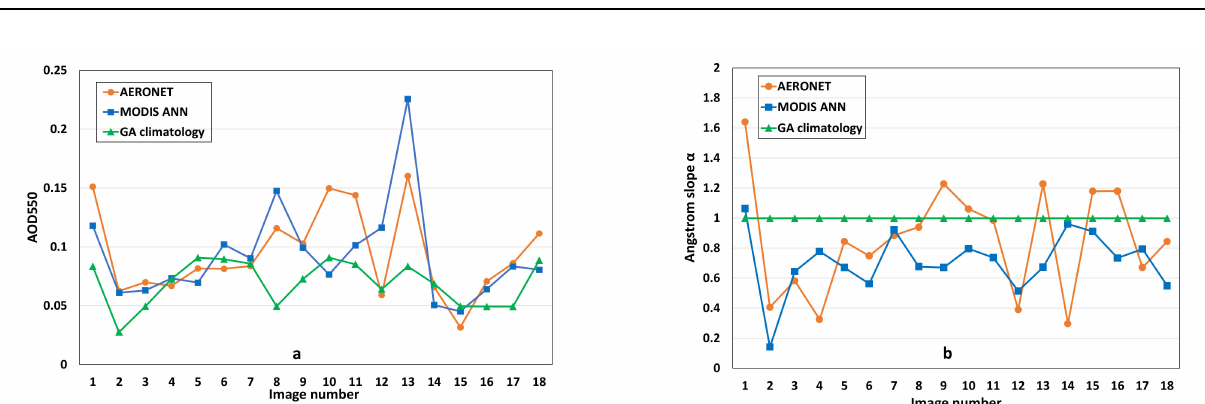
Figure 2. AOD at 550 nm ( a ) and Ångström slope α ( b ) for the 18 images at LJCO site. In Figure 2b, the MODIS Ångström slope data seem to be more “damped” than the CIMEL data, or at least they seem to be without some of the high values. They both sense a high Ångström slope at overpass image 1. This could be due to the dust from the land, and the AOD 550 values are also relatively high as well. More extreme results may relate to the time difference between the Landsat and MODIS AQUA overpasses. The mean Ångström slope for the MODIS data is a little low at 0.7103, whereas, for the CIMEL data,